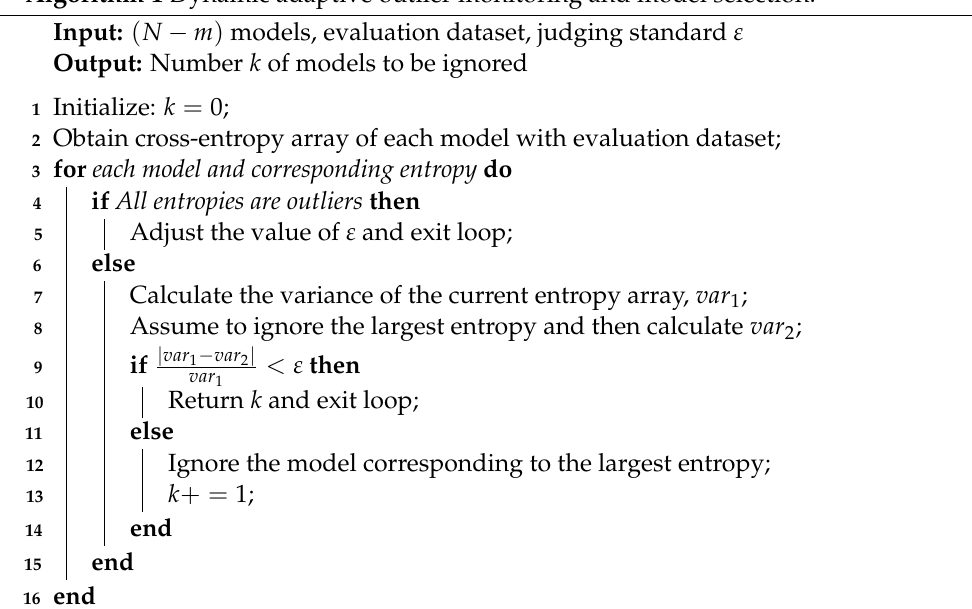
Algorithm 1 Dynamic adaptive outlier monitoring and model